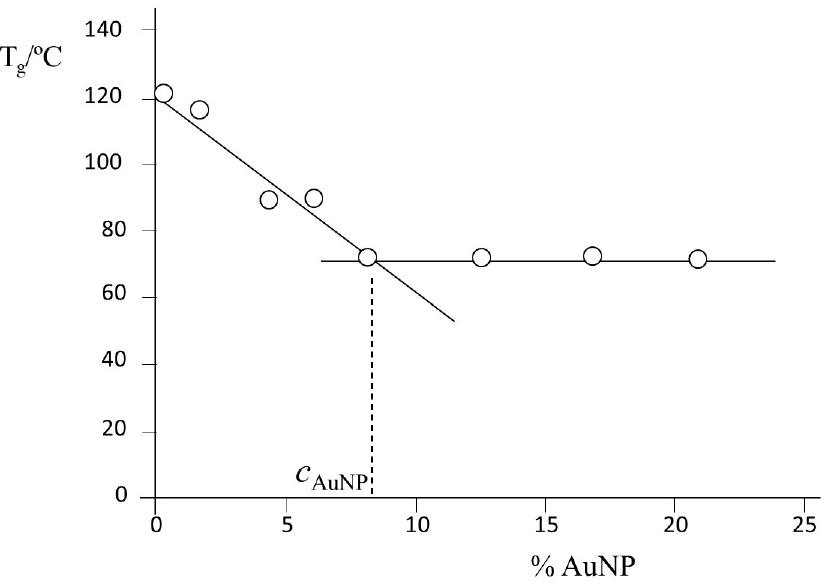
Figure 1. Dependence of the glass transition temperature ( T g ) of the DGEBA/mXDA/AuNP nanocomposite with the amount of AuNPs.